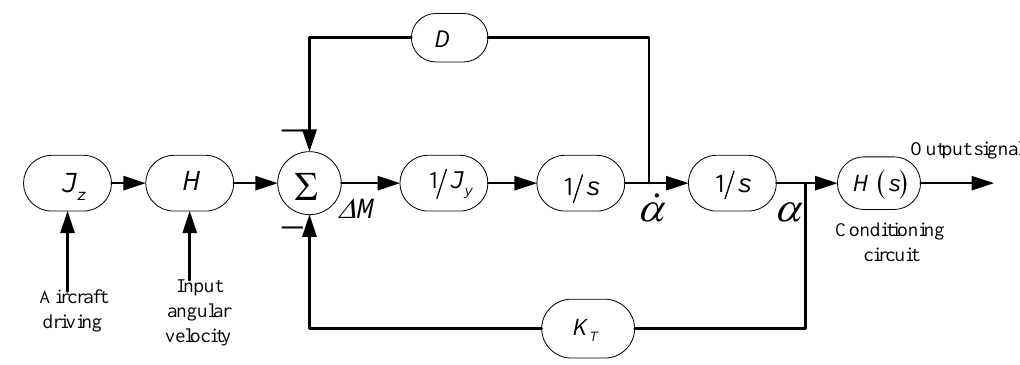
Figure 14. Block diagram of gyro working